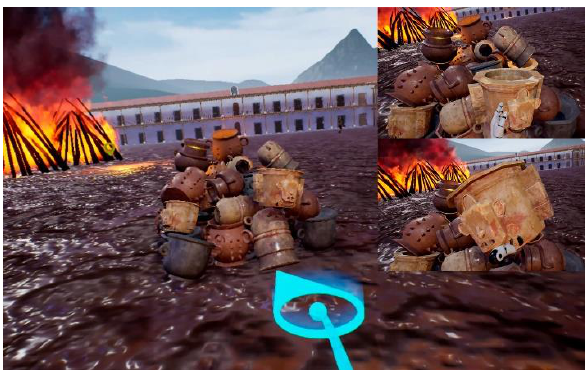
Figure 9. Pile of “idols” or god images in center of the